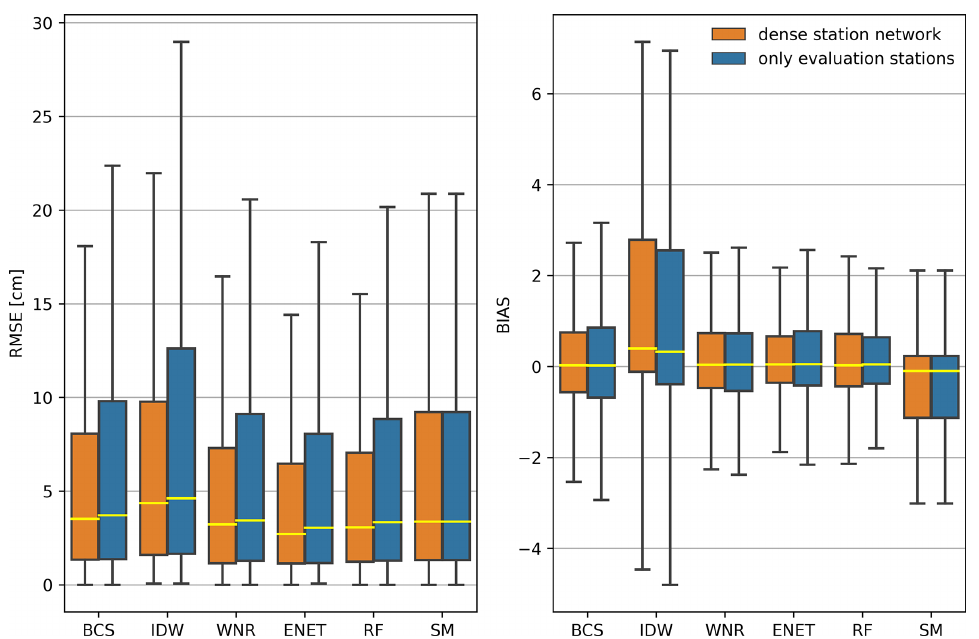
Figure A2. Box plots for root mean squared error (RMSE) and bias of the daily values for the different methods and station densities. The maximum number of predictors for the different methods is set as defined in Table 1. The station network density is irrelevant for the snow model as no data from neighboring stations are used. For better comparison, outliers are not shown in the box